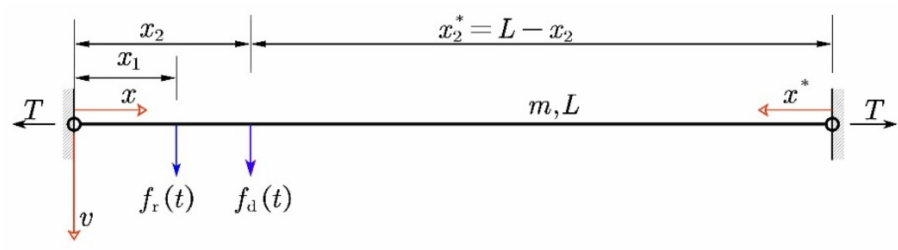
Figure 2. Cable with two transverse